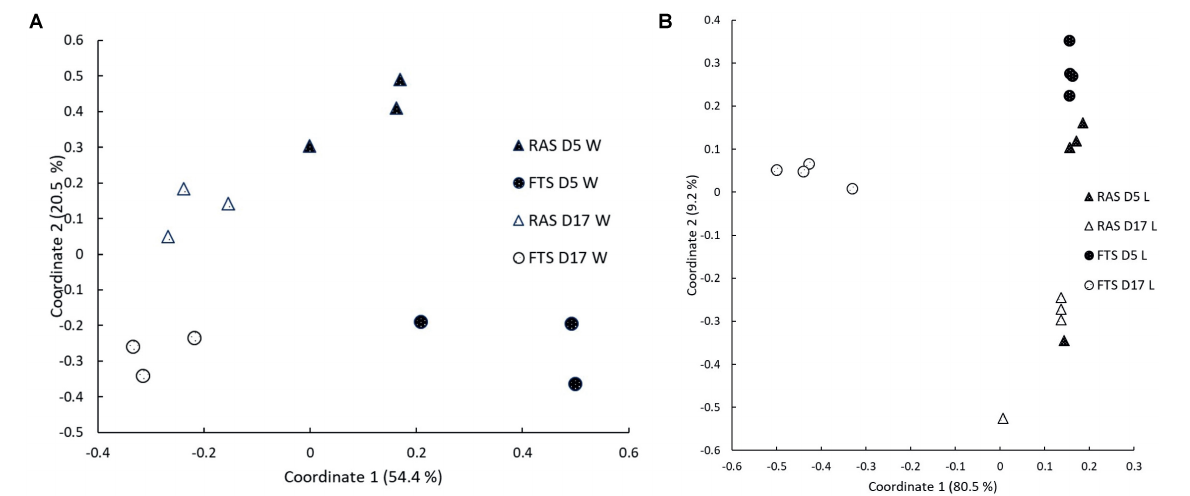
analysis for samples from 5 and 17 dph. PCoA